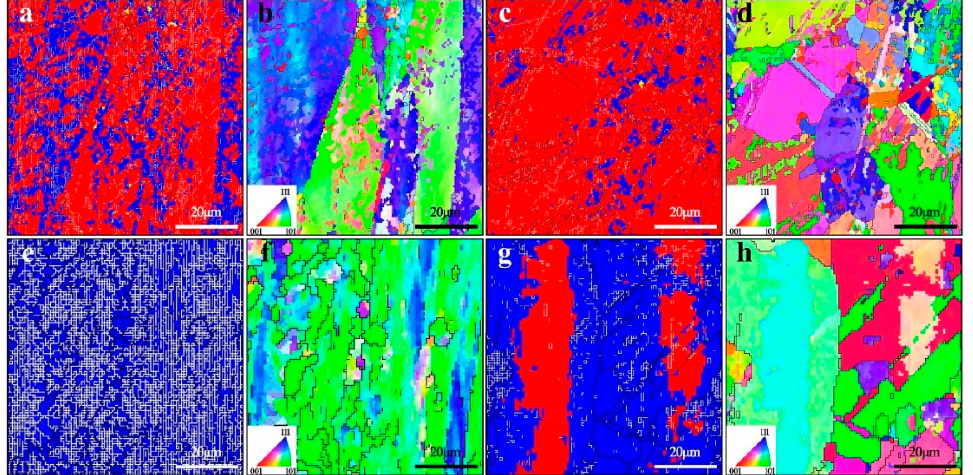
Figure 8. EBSD diagrams of the specimens with different carbon contents under different heat treatment states; ( a , c , e , g ) are phase maps of specimens 0.2C-AC-F, 0.2C-AC-F-AN, 0.5C-AC-F and 0.5C-AC-F-AN, respectively, red represents the HCP phase and blue represents the FCC phase; ( b , d , f , h ) are IPF maps of specimens 0.2C-AC-F, 0.2C-AC-F-AN, 0.5C-AC-F and 0.5C-AC-F-AN, respectively.